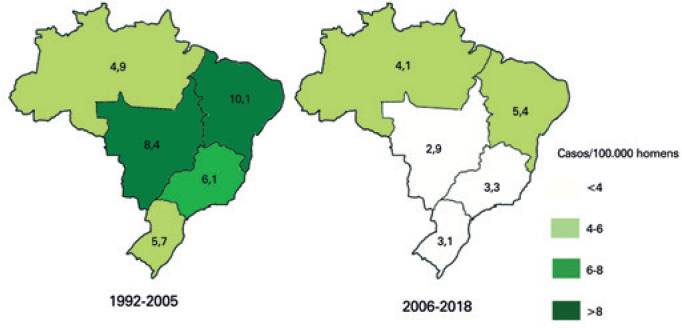
Incidência de internações por câncer de pênis por 100 mil homens, segundo regiões brasileiras, de 1992 a 2005, e de 2006 a 2016